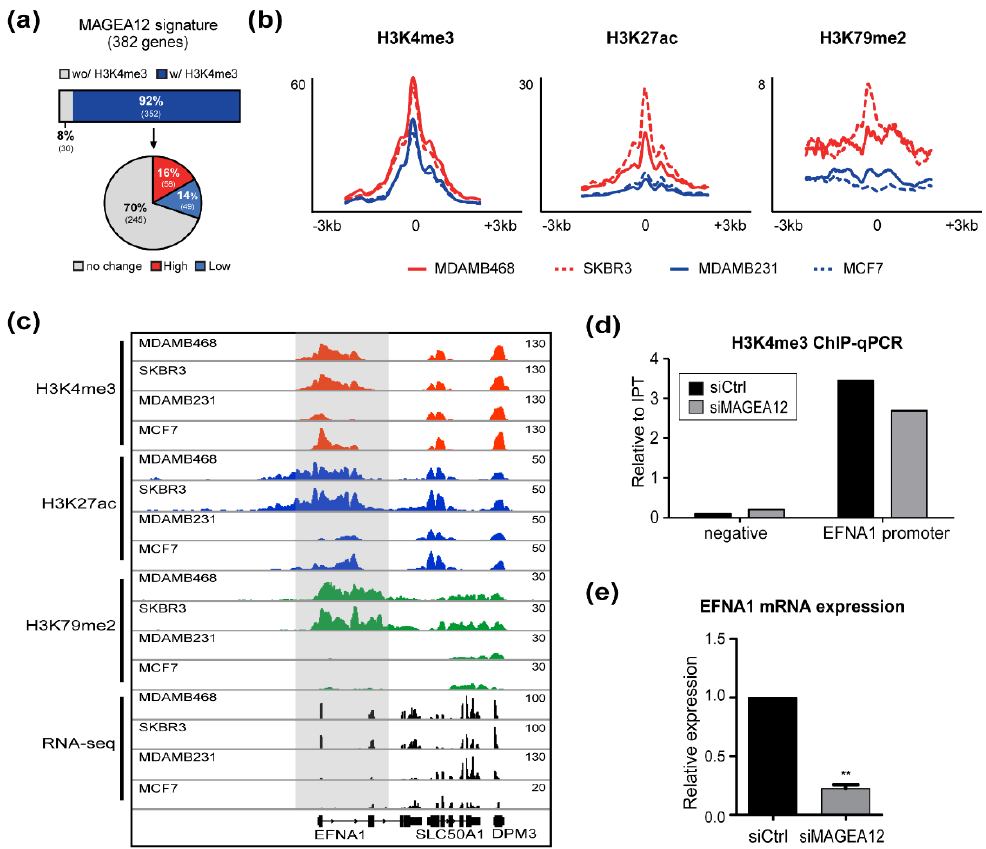
Figure 7. MAGEA12 levels parallel the levels of active histone modification markers in a subset of genes in breast cancer cells. ( a ) The bar graph ( top ) shows the frequency of the 382 MAGEA12 signature genes that did and did not bear the H3K4me3 marker. Of these genes, 352 bore H3K4me3 markers. The pie chart ( bottom ) shows the proportion of these 352 genes whose H3K4me3 levels were elevated in the high MAGEA12-expressing cells and concomitantly reduced in low MAGEA12-expressing cell lines (MDAMB231 and MCF7) (red), decreased in the high MAGEA12-expressing lines and increased in the low MAGEA12-expressing lines (blue), or did not change regardless of MAGEA12 expression (grey). ( b ) Density plots of H3K4me3, H3K27ac, and H3K79me2 in the four cell lines with high (red lines) or low (blue lines) MAGEA12 expression. ( c ) IGV genome browser snapshot showing the H3K4me3, H3K27ac, and H3K79me2 ChIP-seq and RNA-seq data at the aggr gene locus for the four cell lines with high and low MAGEA12 expression. ( d ) H3K4me3 ChIP-qPCR at the EFNA1 promoter compared with that at a negative control region in siMAGEA12-treated MDAMB468 cells. ( e ) Expression of EFNA1 in siMAGEA12-treated MDAMB468 cells, as determined by qRT-PCR. (** p -value < 0.001) .